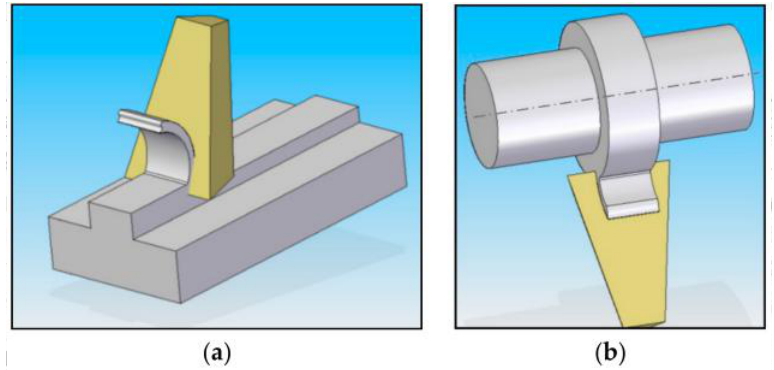
Figure 1. The principle of orthogonal cutting in ( a ) planing and ( b ) turning.